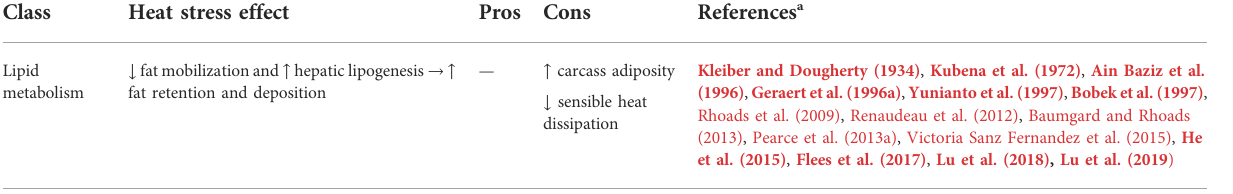
TABLE 2 Overview of heat stress effects on chicken lipid